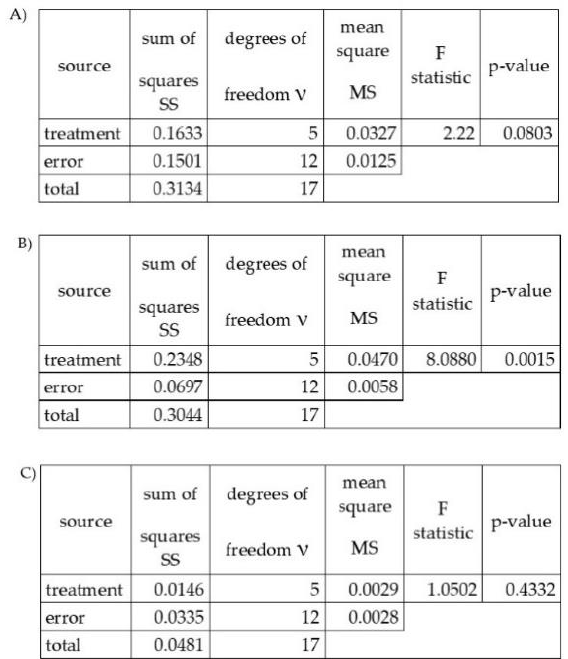
Figure 1. Results of ANOVA for individual microorganism parameters tested in the study. ( A )—total viable count, ( B )—coliform bacteria, ( C )—microscopic filamentous fungi. Using the same matured grapes, antimicrobial activity was investigated further. The diameters of the inhibition zones (in mm) that correspond to the tested pomace extracts are shown in Table